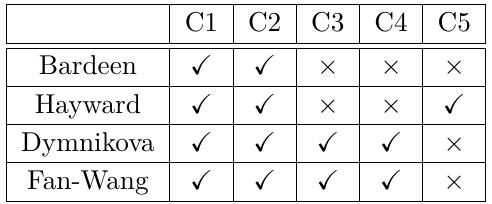
Table 5 . Results of the geometric criteria C1–C5 in section 1 for spherically symmetric non-singular black